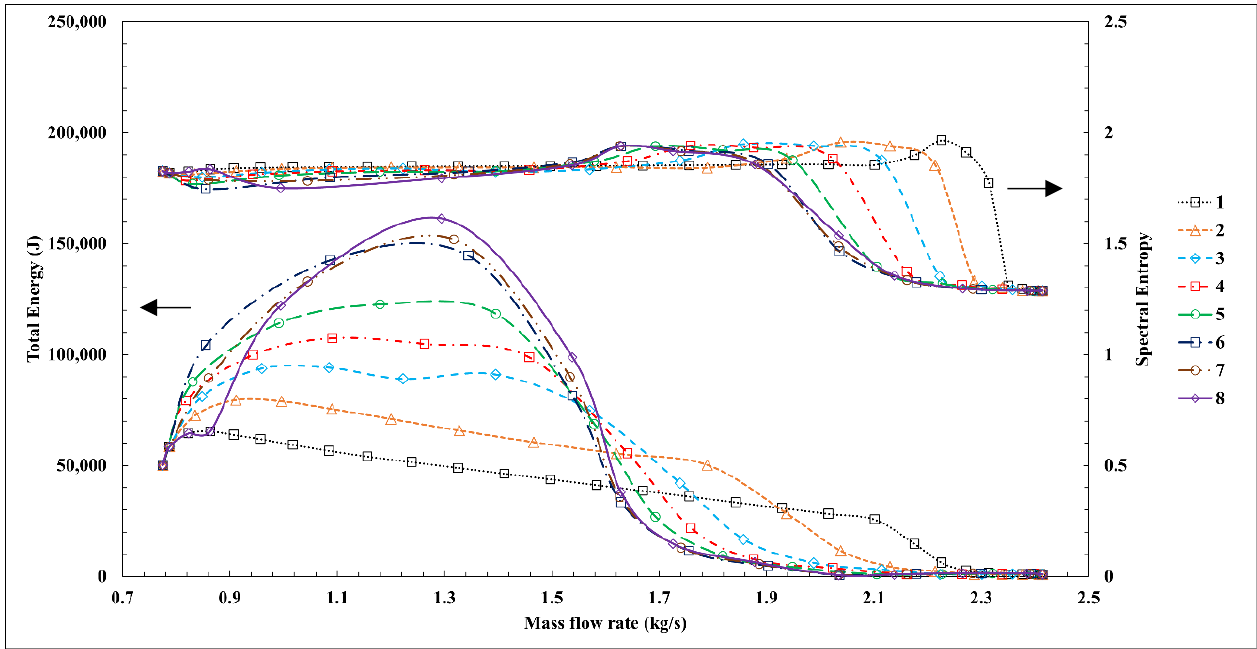
Figure 3. Total energy and spectral entropy versus mass flow rate.